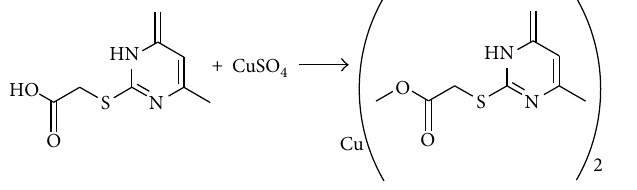
F 5: Syntheses of 2-(3-chloro-2-hydroxypropylthio)-6-meth- ylpyrimidin-4(3 H )-one (V).